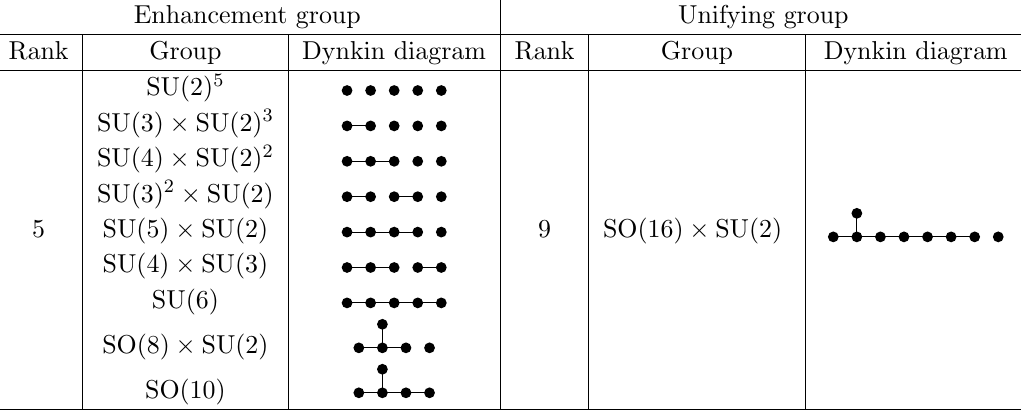
Table 7 . The case T 5